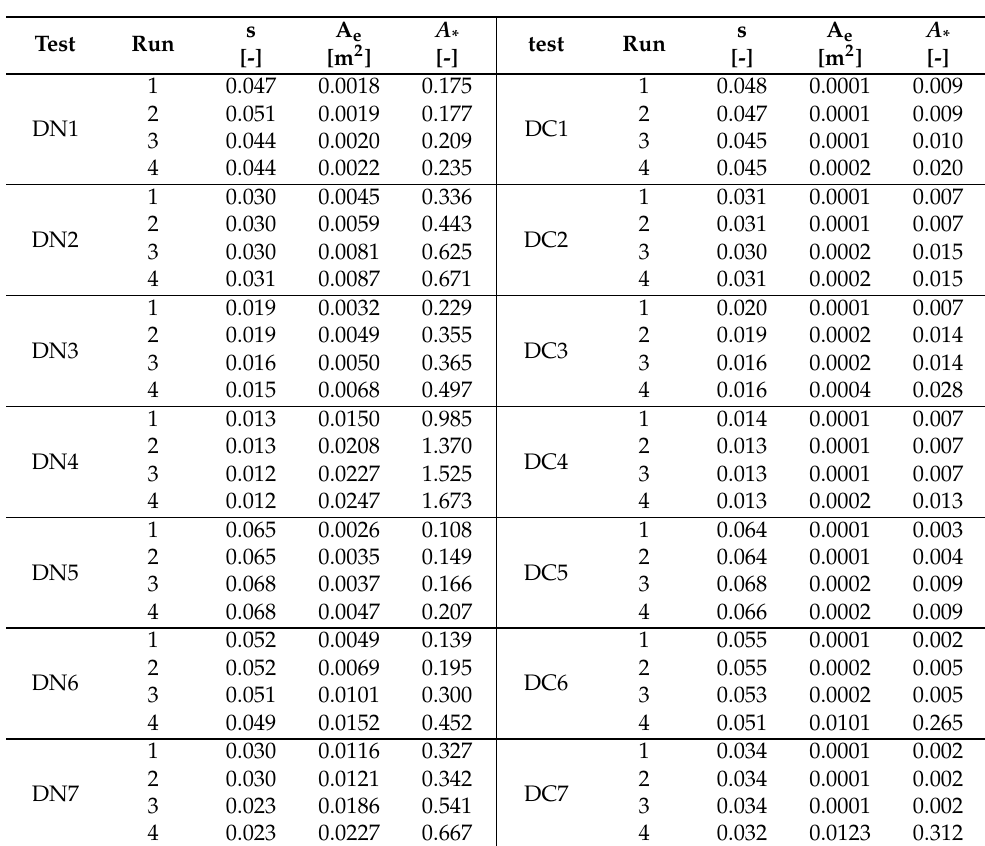
Table 5. Wave steepness s